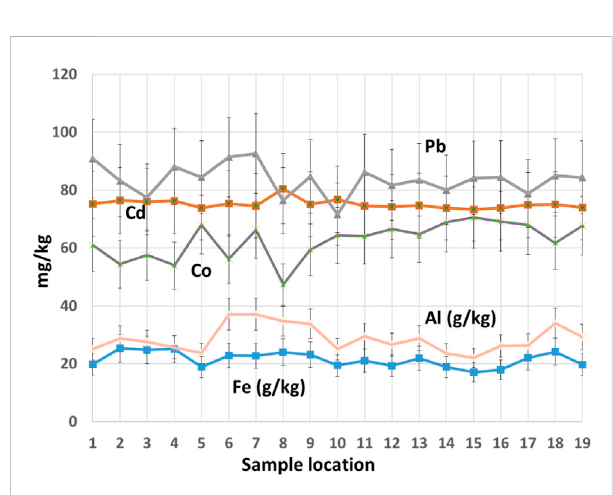
FIGURE 4 Spatial distribution of Al, Fe, Cd, Pb and Co in dusts collected from the Abu Dhabi-Liwa